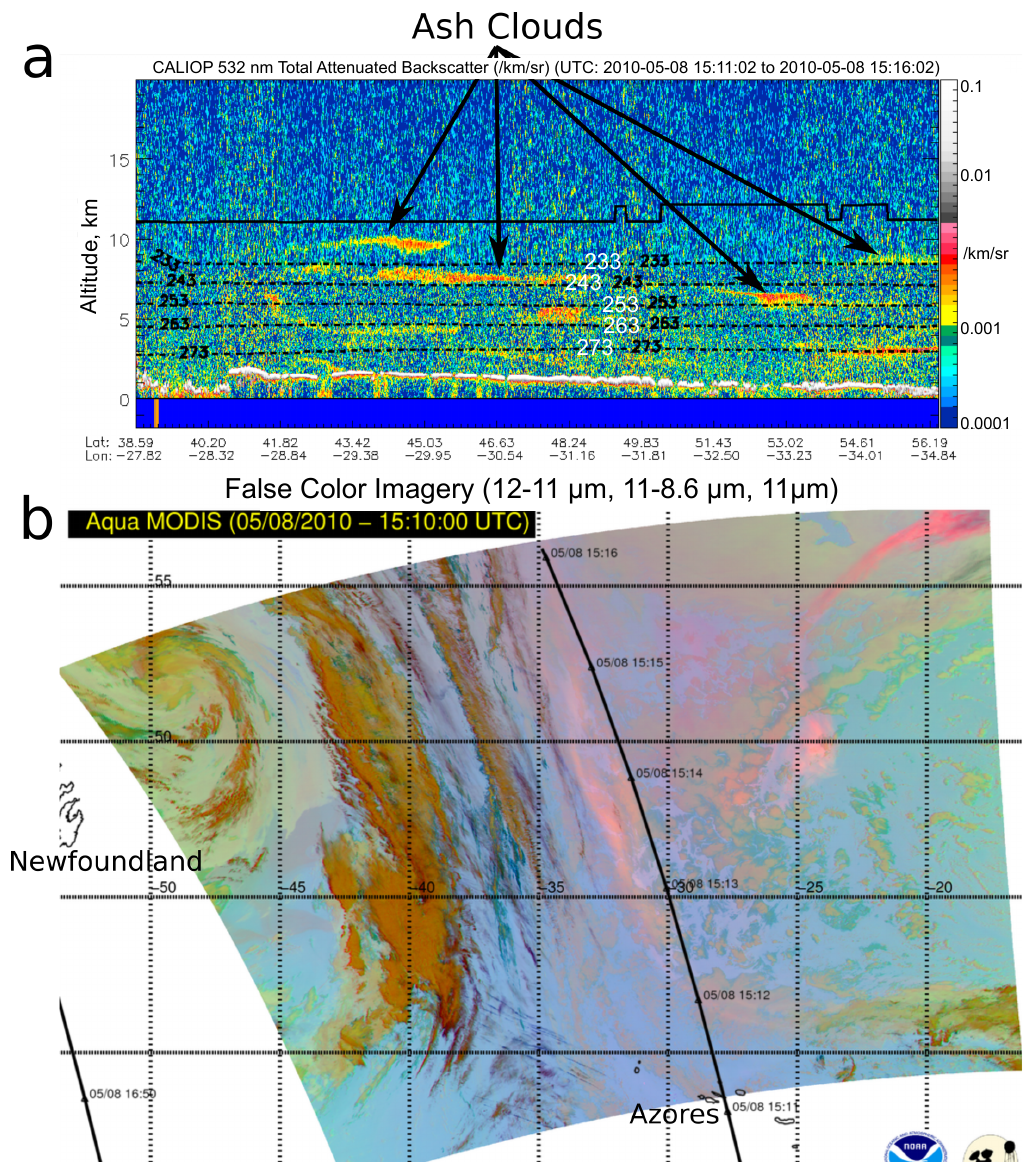
Figure 2. ( a ) CALIOP nadir lidar total attenuated backscatter (along track shown in ( b )) showing complex layering of Eyjafjallajökull ash cloud on 8 May 2010, isotherms (kelvins, black dotted lines) and tropopause (black solid line). ( b ) Aqua-MODIS RGB false color image [9] of North Atlantic capturing this ash cloud (pink hues). In distal regions, volcanic clouds tend to be thin, less concentrated, and often broken into multiple bodies.